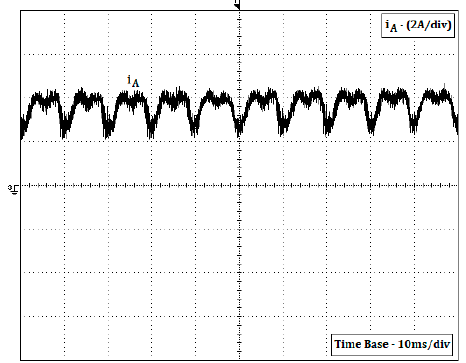
Figure 15. Result of the current in the winding of the motor (i A ).